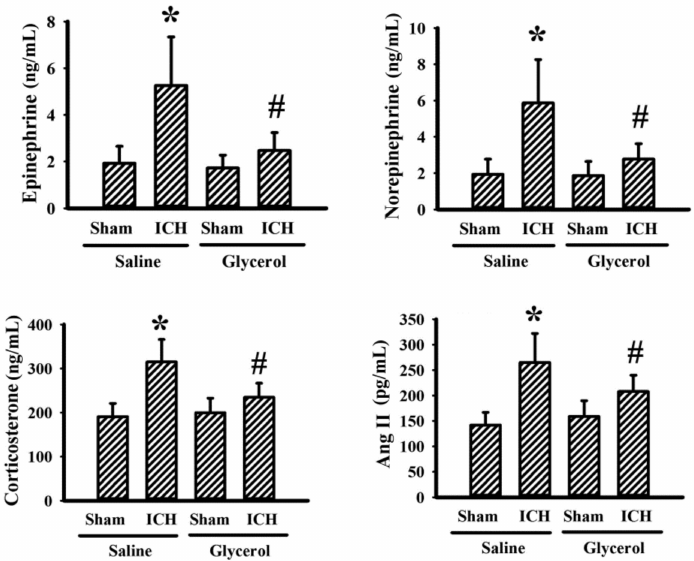
Figure 7. Glycerol alleviated stress hormones in hemorrhagic stroke rats. ICH and sham rats were intraperitoneally injected with saline or glycerol and housed for an additional 24 h. Serum samples were subjected to ELISA for the measurement of epinephrine, norepinephrine, corticosterone, and Ang II. * p < 0.05 vs. sham/saline and # p < 0.05 vs. ICH/saline, n =